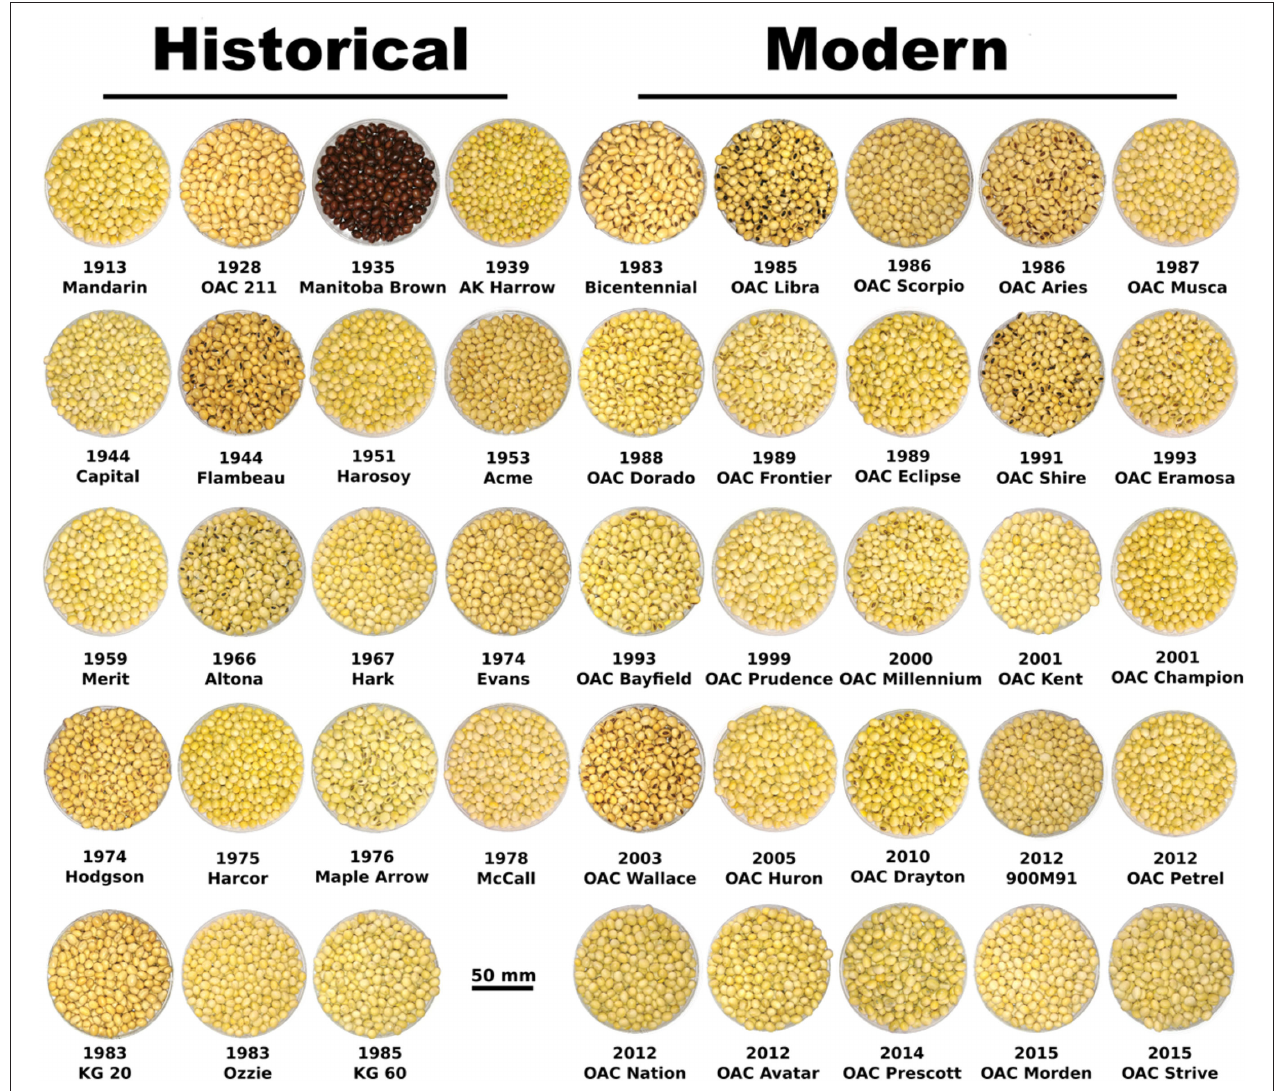
FIGURE 1 | Images of historical (19) and modern-Guelph (25) soybean cultivars used in this study with name and release